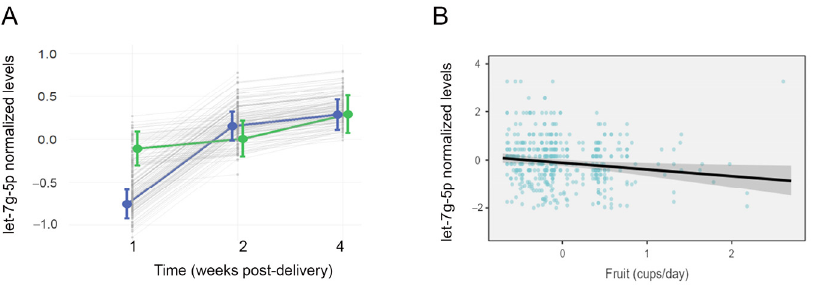
Figure 3. Milk levels of let-7g-5p differ over time among mothers with low milk supply and are related to maternal fruit intake. The effects plot displays normalized concentrations of let-7g-5p in 453 samples from 170 lactating mothers across three time points: 1 wk, 4 wks, and 16 wks after delivery ( A ). Mean concentrations are shown for mothers with low milk supply (LMS, green), and mothers with adequate milk supply (AMS, blue). There was a significant interaction effect ( p < 0.001) between LMS/AMS group and time (F = 7.5), with let-7g-5p levels increasing between 1 wk and 4 wks post-delivery in the AMS group only. ( B ) A second mixed effects model also revealed a significant effect of maternal fruit consumption on milk levels of let-7g-5p (F = 5.99, p = 0.015). Higher levels of let-7g-5p were associated with lower fruit consumption, as reported longitudinally on the Dietary Screener Questionnaire.